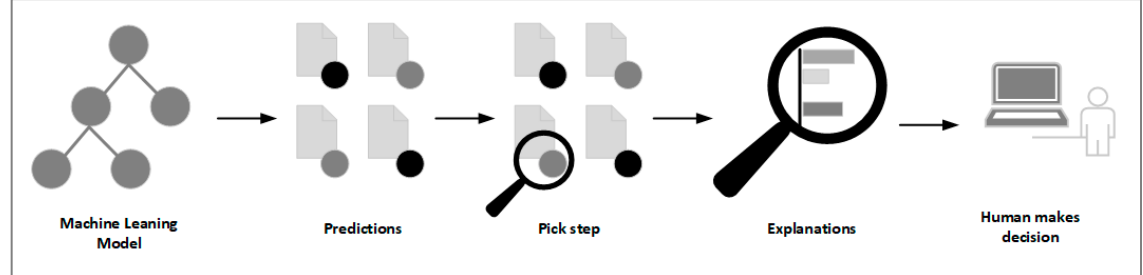
Figure 3. Workflow of decision-making of the Explainable AI.